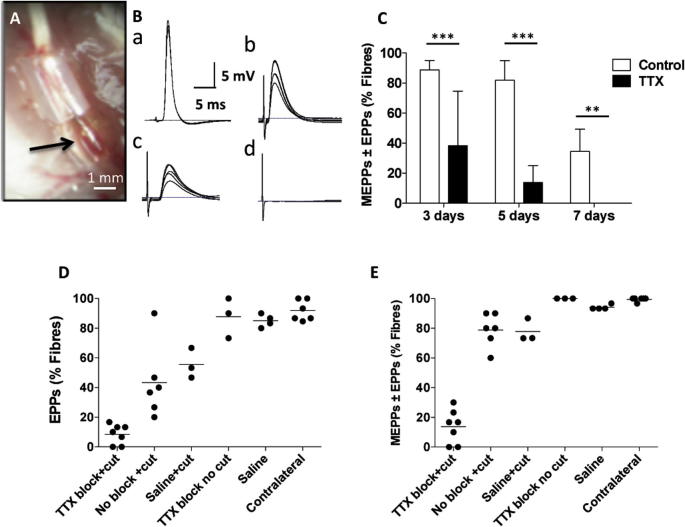
TTX block sensitizes synapses to axotomy. (A) TTX-impregnated capillary (arrow) in situ, with its opening secured to the exposed sciatic nerve of a WldS mouse, via silicone rubber cuff. (B) Representative intracellular recordings obtained 5 days after axotomy from WldS mice: (a) no axotomy (contralateral control); (b) saline implant; (c) TTX block only; (d) TTX-block then axotomy. (C) Time course of loss of functional innervation in axotomized, saline vehicle control muscles (open bars), compared with preconditioning TTX block (filled bars); mean ± S.E.M., n = 4–7 muscles per group. (D) Complete data from six groups of mice showing the incidence of responsive fibers, 5 days after axotomy in those indicated as cut. From left to right, the categories were as follows; TTX block + cut: sciatic nerve block for 7 days followed by section of the tibial nerve; No block + cut: tibial nerve section only; Saline + cut: saline vehicle infusion of the sciatic nerve for 7 days, followed by section of the tibial nerve; TTX block no cut: sciatic nerve block for 7 days only; Saline – saline vehicle infusion of the sciatic nerve only; Contralateral – data from muscles on unoperated contralateral sides of the TTX block + cut group. (E) As in C, but complete data including fibers that showed only MEPPs on intracellular recording. TTX block + cut groups are highly significantly different from the other groups (P < 0.01, ANOVA/Bonferroni).